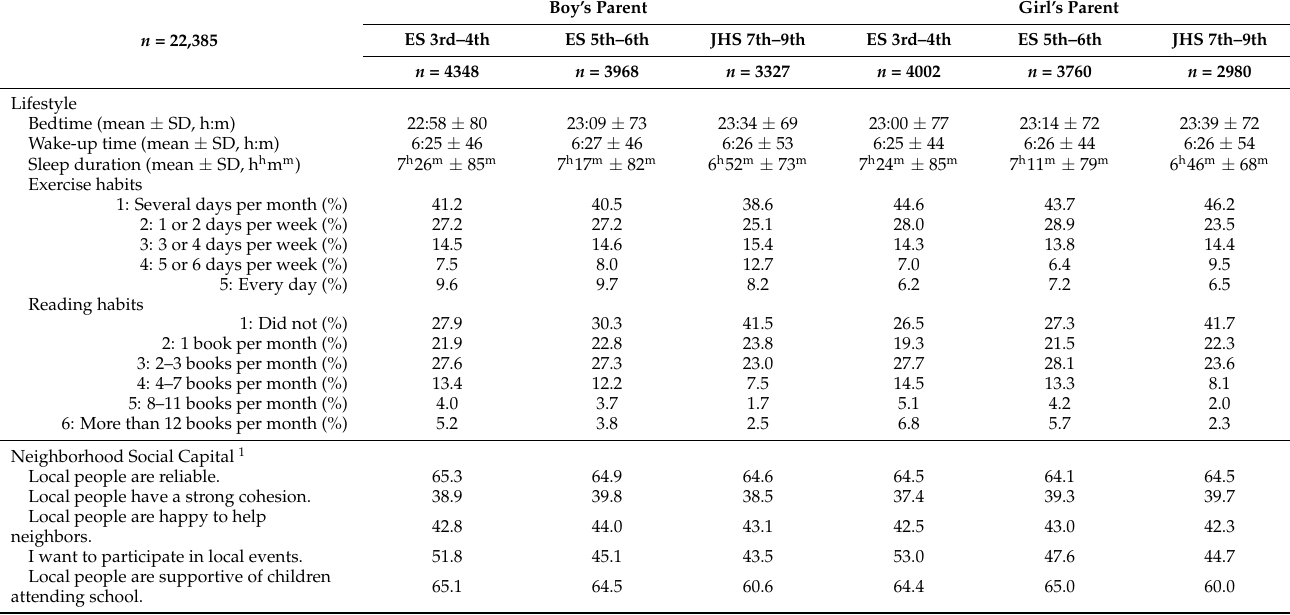
Table 2. Parental lifestyle and neighborhood social capital by sex and grade level of their child. Boy’s Parent n = 22,385